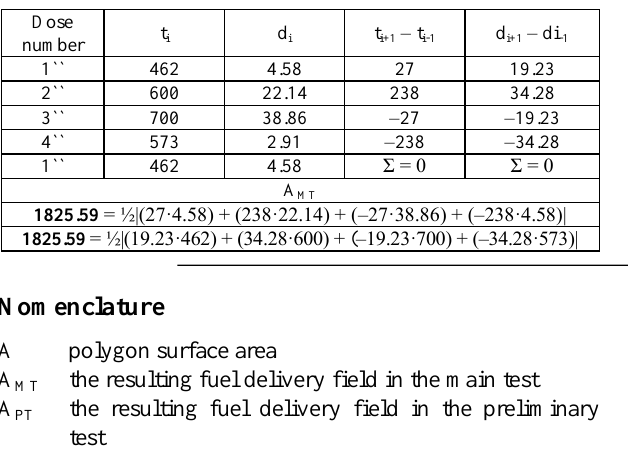
Table 6. Calculation of the resultant fuel metering field A MT